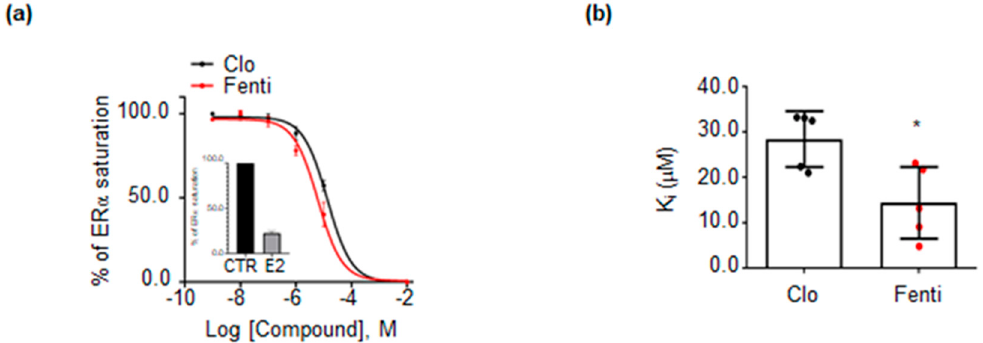
Figure 2. Validation of in vitro binding of clotrimazole and fenticonazole to the ER α . ( a ) In vitro ER α competitive binding assays for clotrimazole (Clo–black) and fenticonazole (Fenti-red) were performed at different doses of the compounds and using a florescent E2 as a tracer. Inset shows the in vitro ER α competitive binding assays for E2 (10 − 7 M). ( b ) Relative inhibitor concentration 50 (IC 50 – μ M, i.e., K i ). The experiment was performed twice in quintuplicate. * indicates significant differences, calculated with the Student t-test, with respect to Clo, * p -value < 0.05.